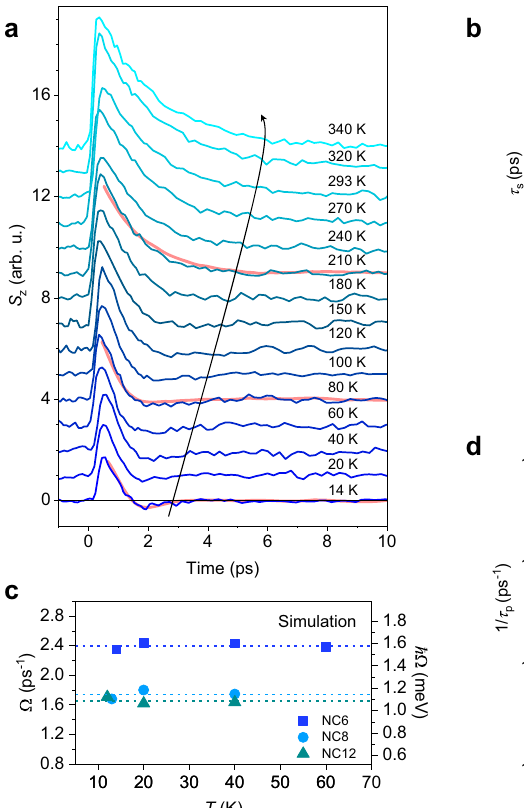
the interruptionofspin precession by changing the direction of themagnetic fi eld viamomentumscattering,andtheEYprocesswherethespin- fl ipmayoccurdueto thechangeofmomentum k . c Thecorrespondingprecessionfrequencyandenergy for different NCs extracted from the oscillatory dynamics at low temperatures. d Simulatedmomentumscatteringrateforthemotionalnarrowingprocess.Linear fi ts(dash linesand theshading)to thetemperature(~ T )are givenforallthreesizes above 100K. The inset shows the simulated temperature dependence of the EY process. Source data are provided as a Source Data fi